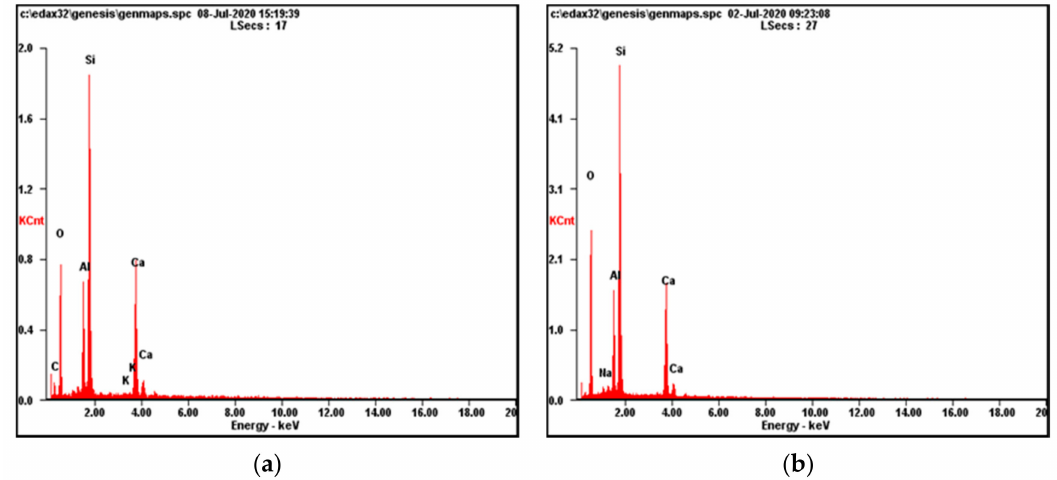
Figure 3. EDX analysis for ( a ) fiberglass waste; ( b ) fiberglass waste treated with hydrogen